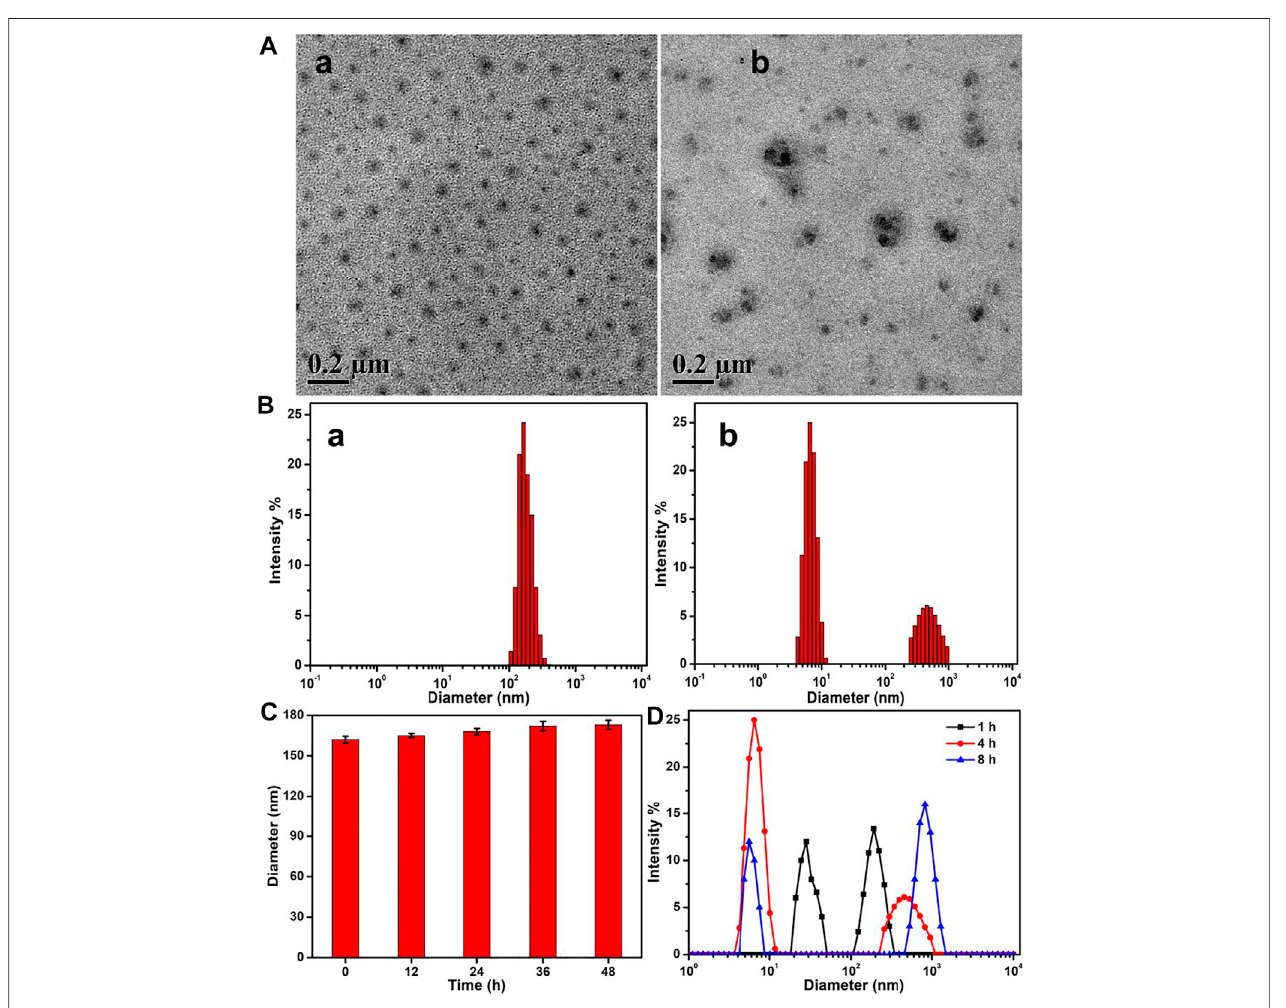
FIGURE 3 | (A) TEM images and (B) size changes of the PEG – disul fi de – DOX micelles before (a) and after (b) treatment of 10 mM reducing agent of DTT solutions for 4 h. (C) Size variations of the PEG – disul fi de – DOX micelles after treatment in PBS (pH (cid:1) 7.4) solutions. (D) Size variations of the PEG – disul fi de – DOX micelles after treatment of 10 mM reducing agent of DTT solutions for various times. The PEG – disul fi de – DOX micelles possessed reduction-responsive degradation in a high concentration of reductive agents, but displayed good stability at physiological conditions for a long